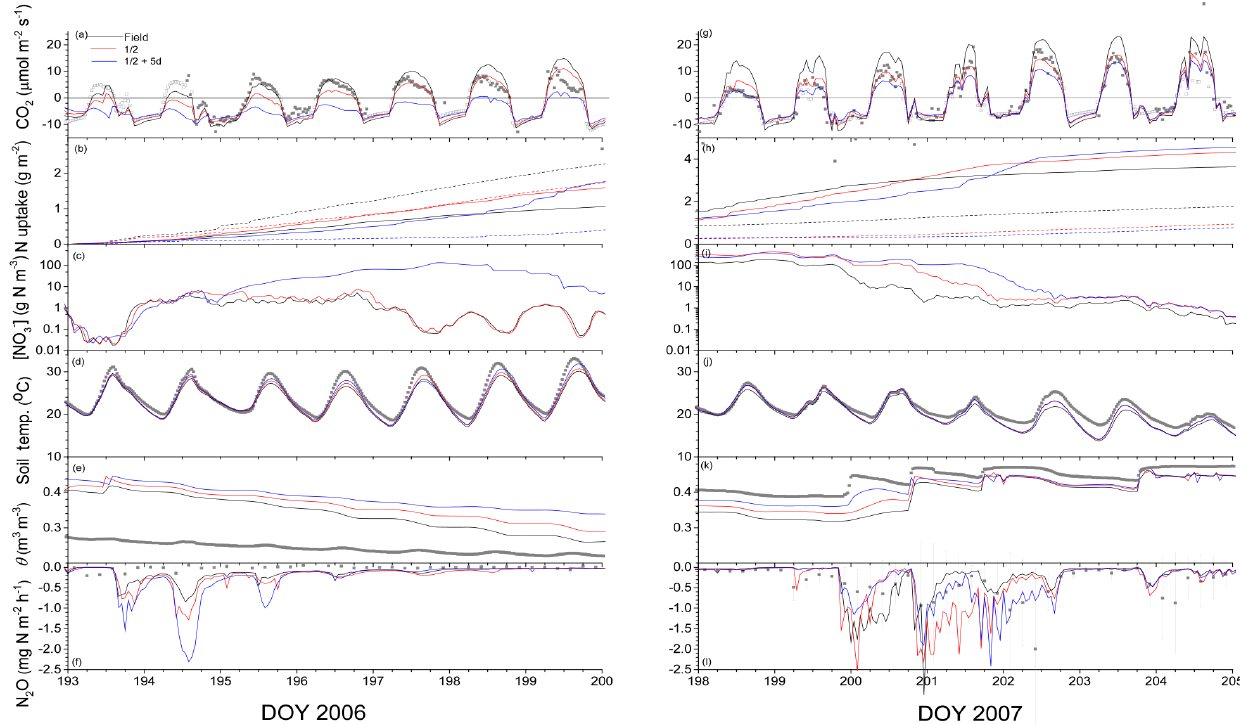
Figure 7. (a, g) CO 2 fluxes, (b, h) cumulative NH + (dashed) and NO − (solid) uptake since manure application, (c, i) aqueous NO − 4 3 concentrations at 0–1cm, (d, j) T s and (e, k) θ at 5cm, and (f, l) N 2 O fluxes measured (symbols) and modelled (lines) with LAI after each cut reduced to half of that estimated from the field experiment without or with a delay of 5 days during emission events following manure applications on DOY 194 in (a–f) 2006 and (g–l) 2007 (see Table 2). For fluxes, positive values represent influxes to the soil, negative values effluxes to the